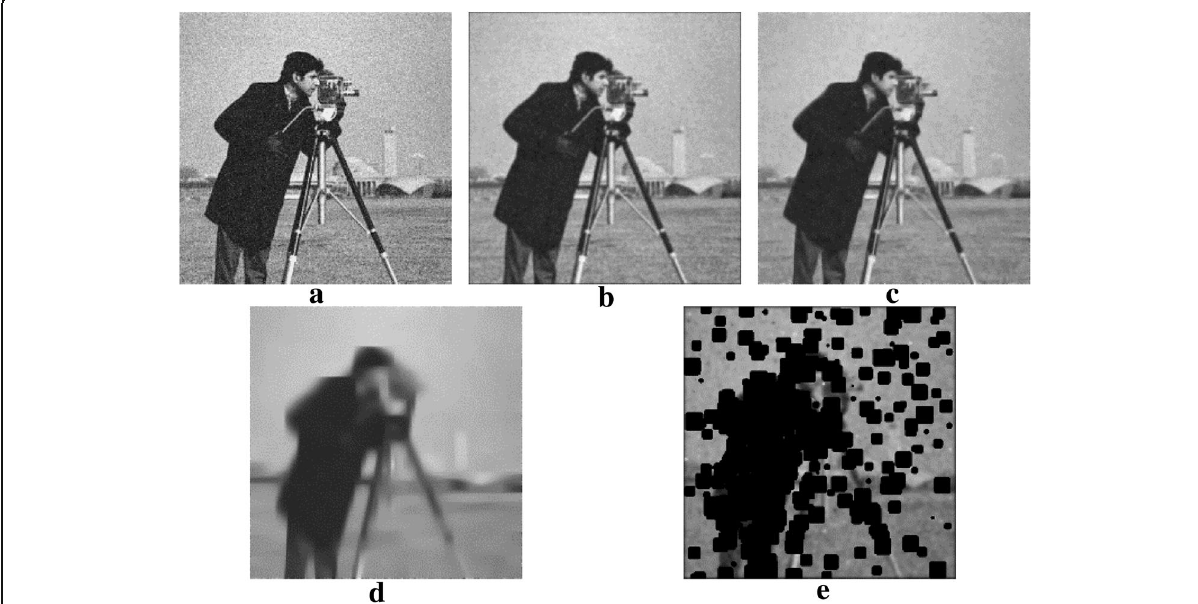
Fig. 1 Comparison of a noisy image, b PM as a smoother at n = 5, c FORADF as a smoother at n = 5, d FORADF at n = 25, and e the spreading effect in PM. Noisy image a is corrupted with Gaussian noise of variance 0.1. n represents the number of iterations. The dark patches indicate the spreading effect in PM